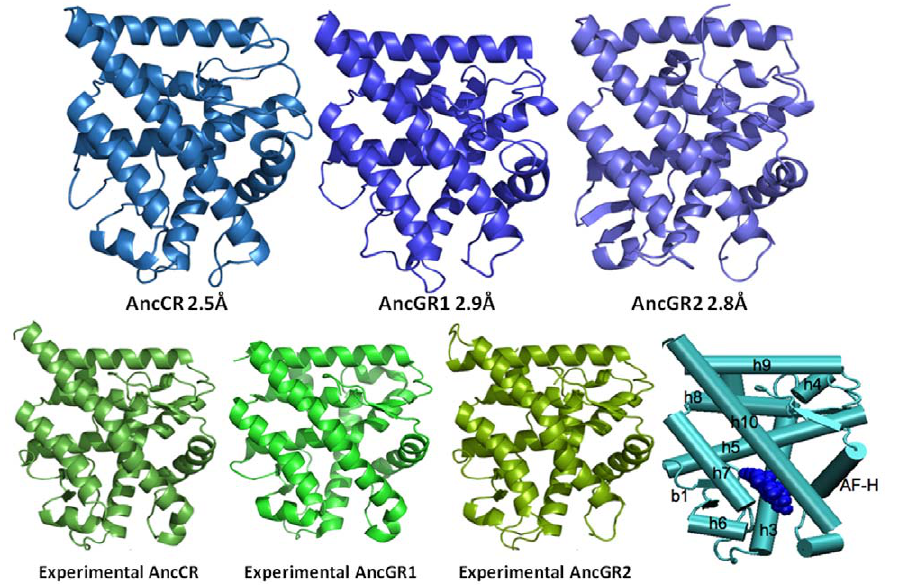
Figure 1. 3D structures of AncCR, AncGR1 and AncGR2. AncCR was within 2.5 A˚ all-atom RMSD from the experimentally determined AncCR. AncGR1 was within 2.9 A˚ all-atom RMSD from the experimentally determined crystal structure. AncGR2 was within 2.8 A˚ all-atom RMSD from the experimentally determined AncGR2. Included for reference is a cartoon figure with helices labeled for reference and the ligand is bound, represented in blue spheres.